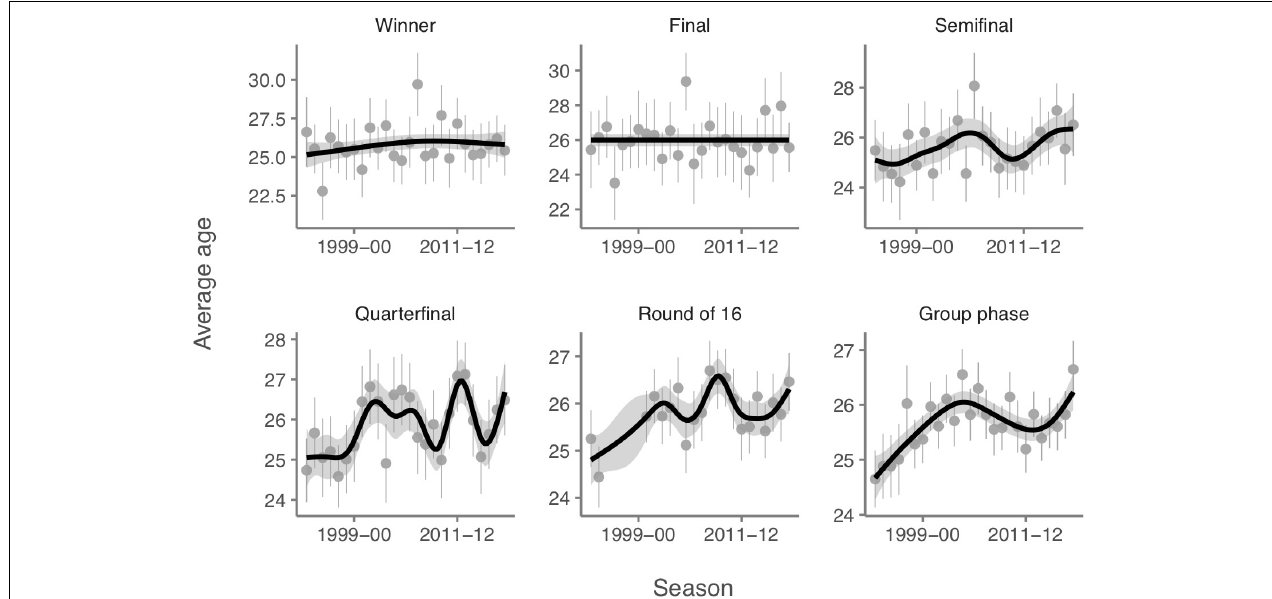
FIGURE 4 | Age trend by team performance.